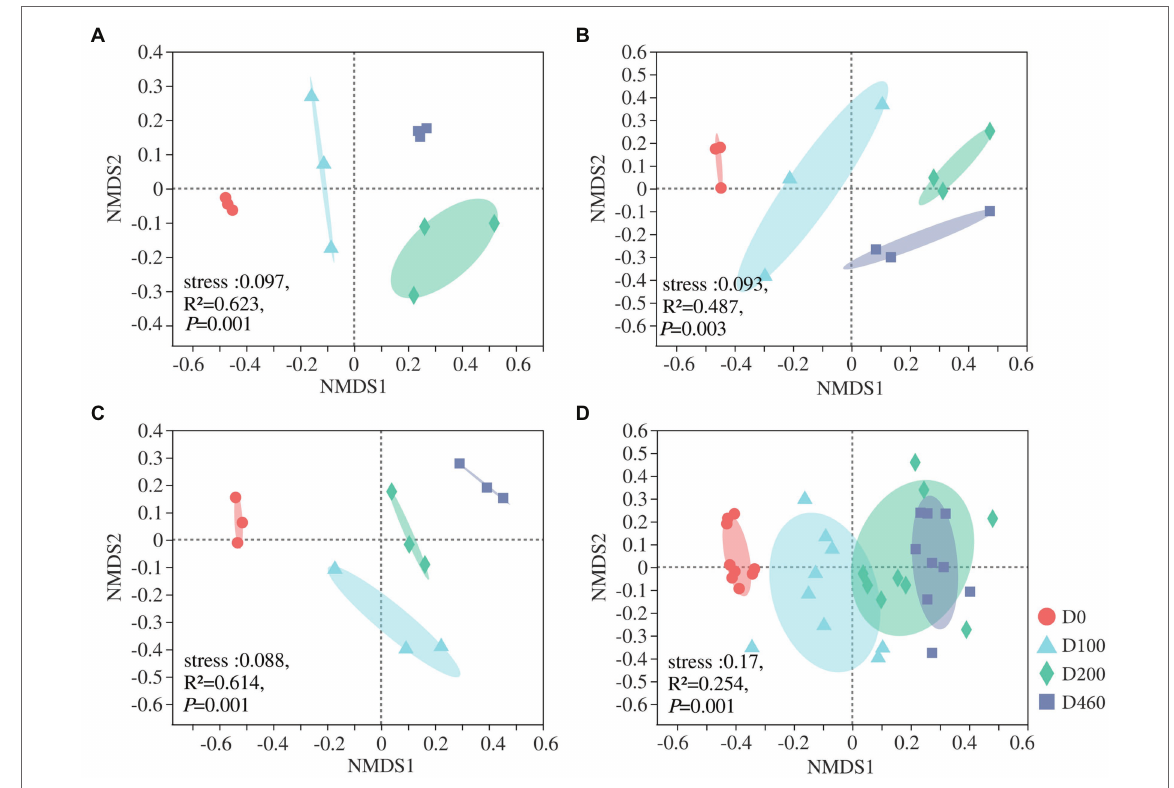
FIGURE 6 | The nMDS of litter fungal community at four decomposition stages in S516 (A) , S536 (B) , S560 (C) , and the whole copper mining area (D)